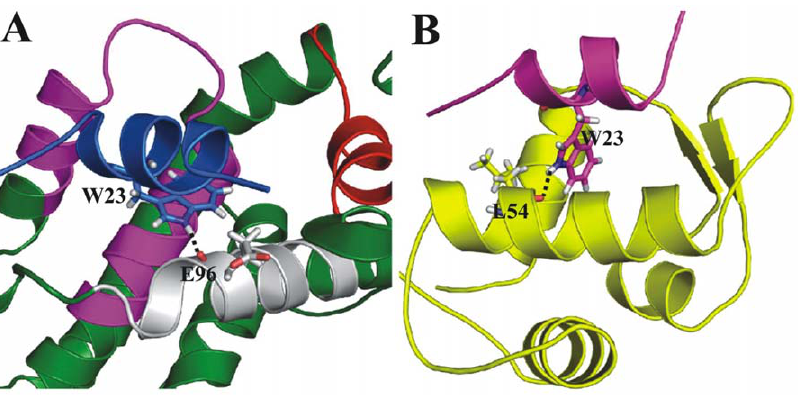
Figure 6. Hydrogen bonding pattern of p53 tryptophan residue. W23 residue of p53 or SN15 forms stable hydrogen bonding interaction with main chain carbonyl of E96 of Bcl-X L are shown (A). Hydrogen bond interaction between W23 of p53 and main chain carbonyl of L54 residue of MDM2 are shown (B). Hydrogen bond represented with black dotted line.